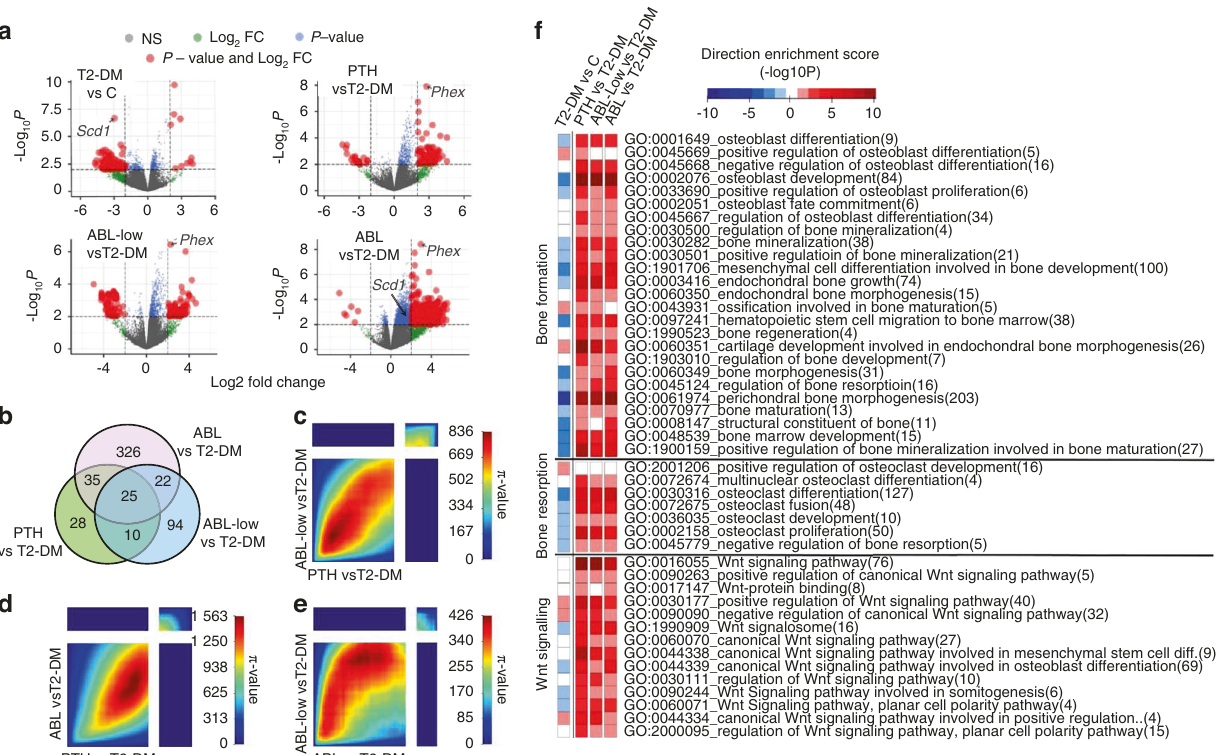
Fig. 4 PTH and ABL generated shared and unique molecular signatures in bone and corrected the dysregulated bone remodeling and Wnt signaling transcriptome induced by T2-DM. a Volcano plots illustrate numbers of signi fi cantly downregulated or upregulated DEGs for each comparison. b Venn diagram depicts the number of unique and shared DEGs in L4 bones. c – e The π -value heatmaps resulting from Rank-Rank Hypergeometric Overlap (RRHO) analysis show high concordance in the gene expression signatures of PTH and ABL in the context of T2-DM. f A directional gene set enrichment analysis of the gene ontology (GO) terms in the DEGs was performed using the PIANO package. The heat map shows the value of the enrichment score (-log10(enrichment P -value)). The GO terms are color-coded to illustrate the direction of the gene expression changes in the majority of genes included in the respective GO term, i.e., red for upregulation and blue for To further evaluate the transcriptional responses of the ligands of decreased the expression of 20 genes; ABL-low increased the the PTH1R, we compared the gene expression signatures of PTH, expression of 72 genes and decreased the expression of 79 genes; ABL-low and ABL in the context of T2-DM using the threshold-free and ABL increased the expression of 402 genes and decreased the approach Rank-Rank Hypergeometric Overlap (RRHO). 18 The RRHO expression of 6 genes (Fig. 4a). Four of the genes upregulated in diabetic bone have been previously associated with glucose analysis detected no discordant transcriptional patterns among homeostasis, lipid metabolism, or pancreatic β cell function treatments (top-left and bottom-right quadrants, Fig. 4c – e). In (Table 1). 11 – 13 Among the genes downregulated by T2-DM, contrast, it detected high concordance in the transcriptionally up- regulated and down-regulated genes (bottom-left and top-right Stearoyl – coenzyme A desaturase-1 ( Scd1 ) was the most signi fi - quadrants, respectively) by PTH and ABL, as analyzed by pairwise cantly downregulated ( − 2.9 fold), and it was conversely sig- comparisons. Moreover, the bigger size of the bottom-left quadrant ni fi cantly upregulated only by ABL ( + 1.4 fold) (Fig. 4a and compared to the top-right quadrant indicates that the majority of Table 1). Scd1 has previously shown to stimulate osteogenic the genes regulated by the treatments were up-regulated. differentiation, 14 and to be downregulated in bone marrow GO enrichment mapping identi fi ed biological processes stromal cells from T2-DM patients. 15 Regulator of G protein affected by T2-DM and/or the treatments with PTH1R ligands. signaling like 1 (Rgsl1) and Forkhead box protein F1 (Foxf1) were Among them, three biological processes were selected: bone also downregulated in T2-DM bones and were upregulated by formation, bone resorption, and Wnt signaling (Fig. 4f). The GO both PTH and ABL. Future studies will be required to establish the term groups of genes related to these three processes were role of these conversely regulated genes in diabetes-induced overall decreased by T2-DM and, conversely, increased by the bone disease and/or PTH/ABL action in bone. different treatments to the same extent, as shown in the heat Consistent with the role of the PTH1R in osteocytes, 16,17 all maps. The gene signatures of bone formation and resorption are treatments increased the expression of several osteocytic genes, consistent with the tissue-level responses to diabetes and the being phosphate regulating endopeptidase X-linked ( Phex ) the treatments with the PTH1R ligands. Speci fi cally, bone formation most signi fi cantly upregulated (PTH + 2.3 fold; ABL-Low + 2.3; rate (BFR) and osteoclast number are decreased in diabetic bone ABL + 3.0) (Fig. 4a). In addition, common and unique set of genes and increased by administration of PTH/ABL. were transcriptionally regulated by PTH vs ABL. Twenty- fi ve genes were transcriptionally regulated by all treatments, while PTH Scl-Ab antibody restored the bone lost with diabetes by increasing exclusively regulated 28 genes, ABL-low 94 genes, and ABL 326 bone formation and reducing osteoclasts genes (Fig. 4b). These fi ndings demonstrate that ABL induced the The GO enrichment mapping also identi fi ed Wnt signaling, a most signi fi cant modi fi cation of the bone gene transcriptome pathway that pays a central role in osteogenesis and the control of compared to PTH in the frame of diabetes.